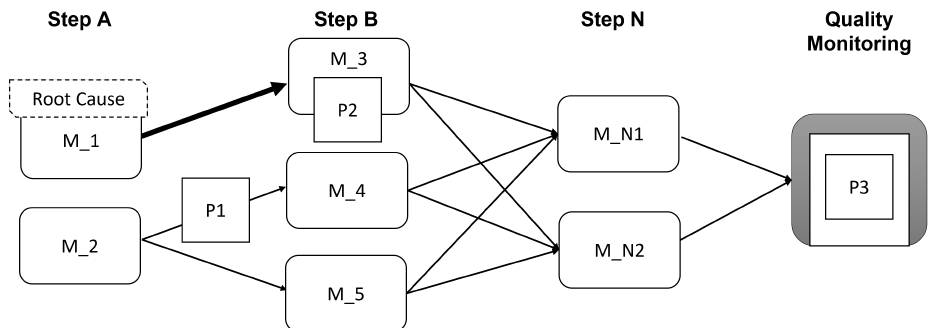
Figure 1. A depiction of an example of a process that produces data that can be used to locate a root cause